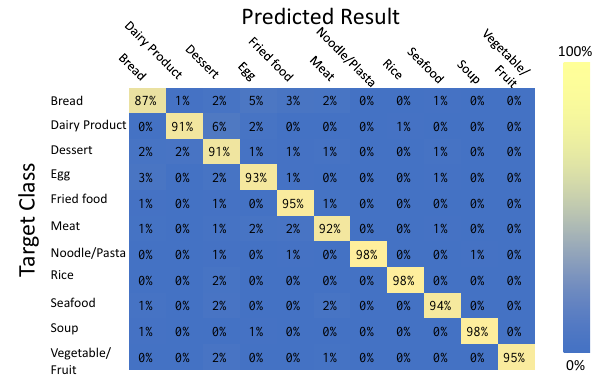
Figure 4. Confusion Matrix of our trained food recognition module.